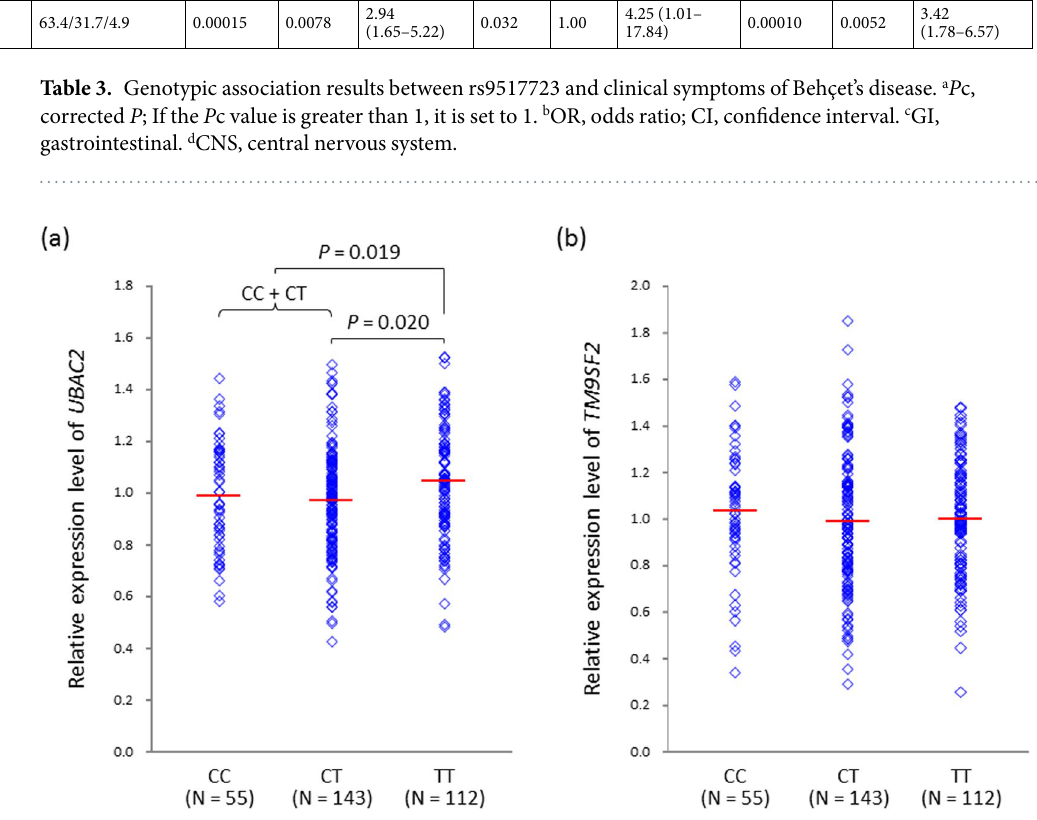
Figure 2. Expression analysis of UBAC2 ( a ) and TM9SF2 ( b ) stratified by rs9517723